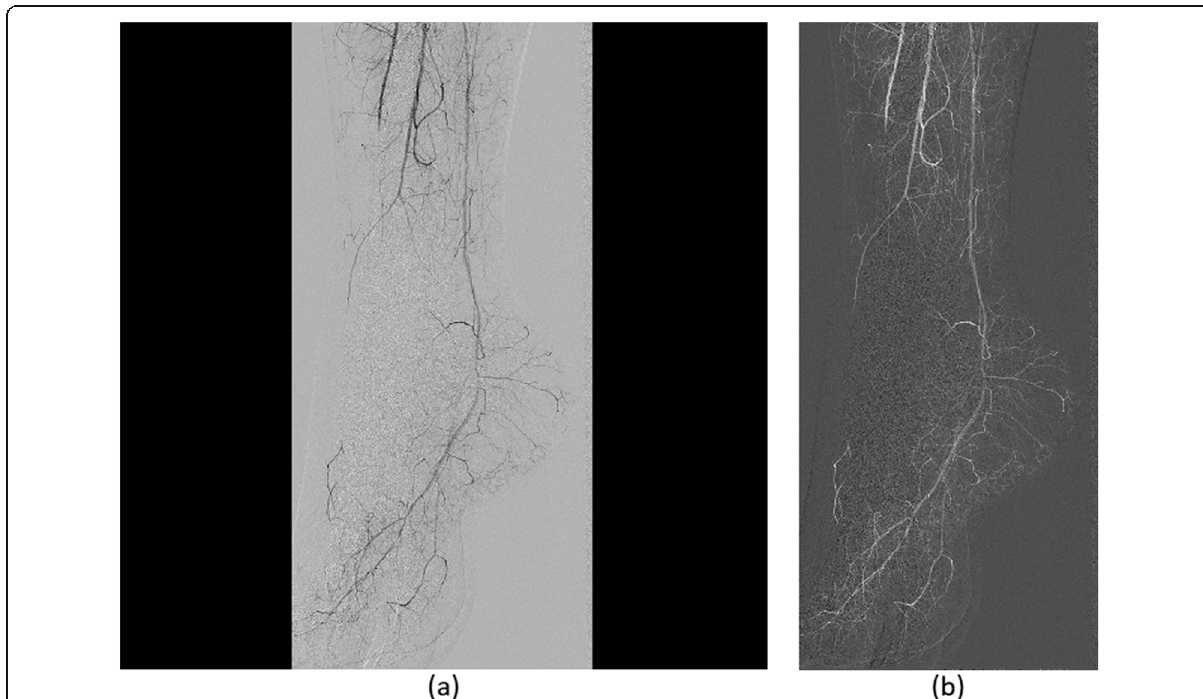
Fig. 2 a Initial digital subtraction angiography image at slice 8/24 (4th second). b Initial image after automatic cropping and complementing